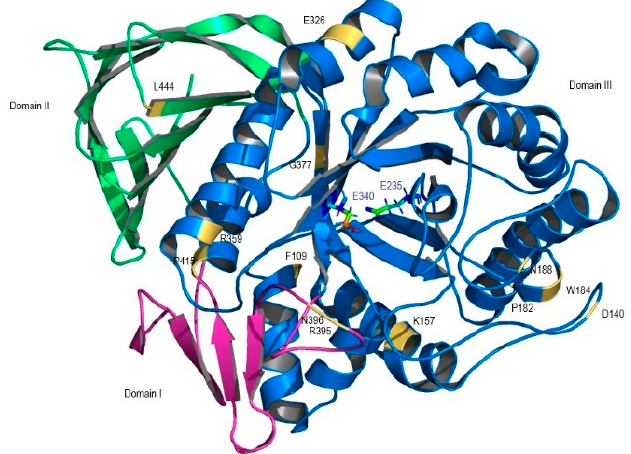
Figure 1. Location of GlcCerase missense mutations considered in this study presented in a solid ribbon model. Domain I is shown in pink, domain II is in green, and domain III is shown is blue. Mutations are identified in yellow. Active site residues (E235 and E340, in blue letters) are shown as ball-and-stick model, with different colors.